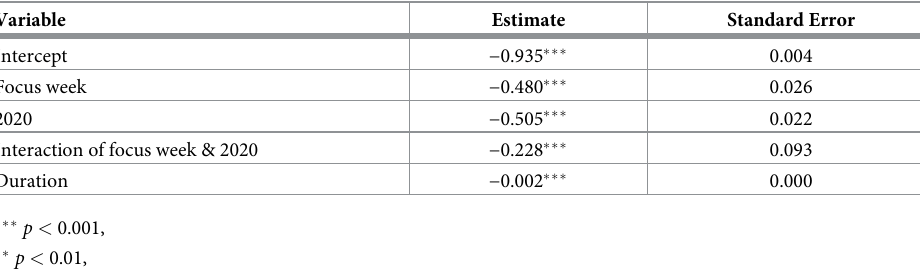
Table 2. Logistic regression model for readmission with additional parameter. As a proxy for reoffense, we use a dichotomous outcome variable indicating whether or not an individual discharged during a given calendar year was readmitted in the same calendar year. The model includes five parameters: an intercept; an indicator fixed effect for release during the week of March 23—29; an indicator fixed effect for release during 2020; an interaction effect for release specifically during March 23—29, 2020; and a fixed effect for incarceration duration. The model is similar to that of Table 1 but adds the duration fixed